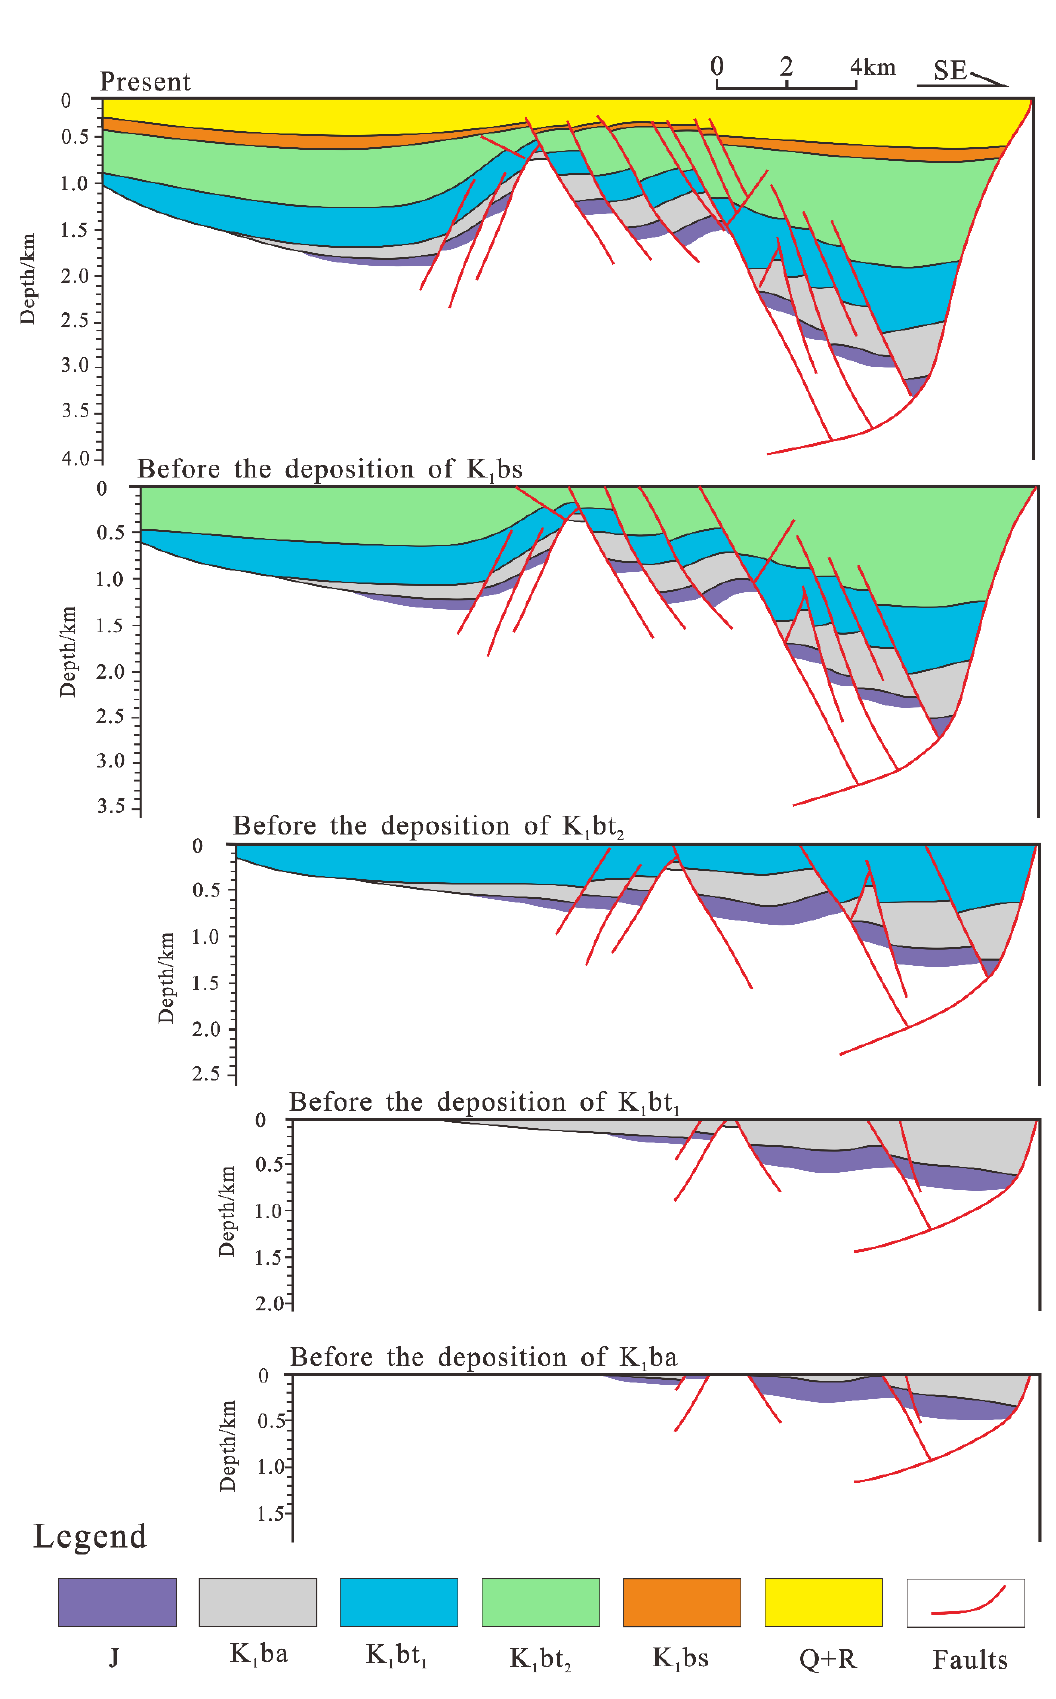
Figure 3. Tectonic evolution map of Saidong sub-sag in Saihantala sag, Erlian Basin [61,62].